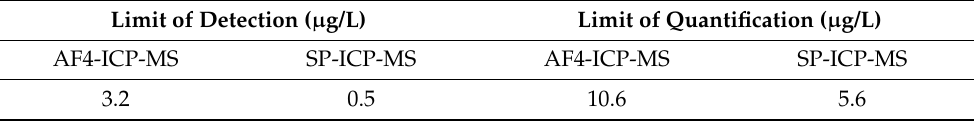
Table 3. Detection and quantification limits of AgNPs in milk using AF4-ICP-MS and SP-ICP-MS. Limit of Detection ( µ